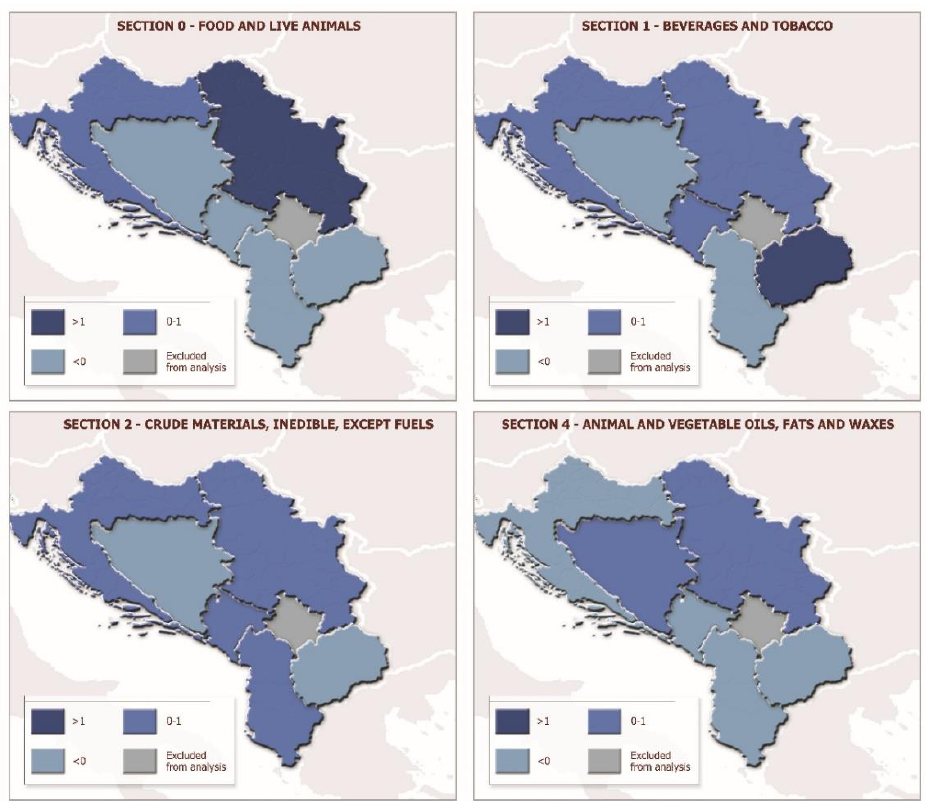
Figure 3. Revealed comparative advantages of sections of the agri-food sector of the WB countries (LFI). Source: own research on basis of UN Comtrade [38]. (LFI). Source: own research on basis of UN Comtrade